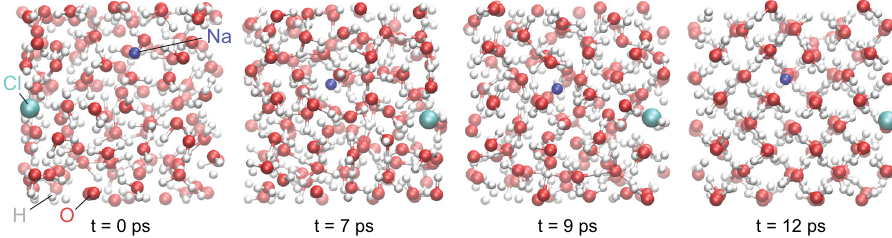
Fig. 1 Crystallization of a NaCl·126H 2 O solution during a DFT-MD simulation at 70 GPa. The simulations are done in the NVT ensemble (constant number of particles, volume and temperature). During crystallization both Na þ and Cl − ions occupy body-centered cubic lattice sites and both substitute a water molecule.